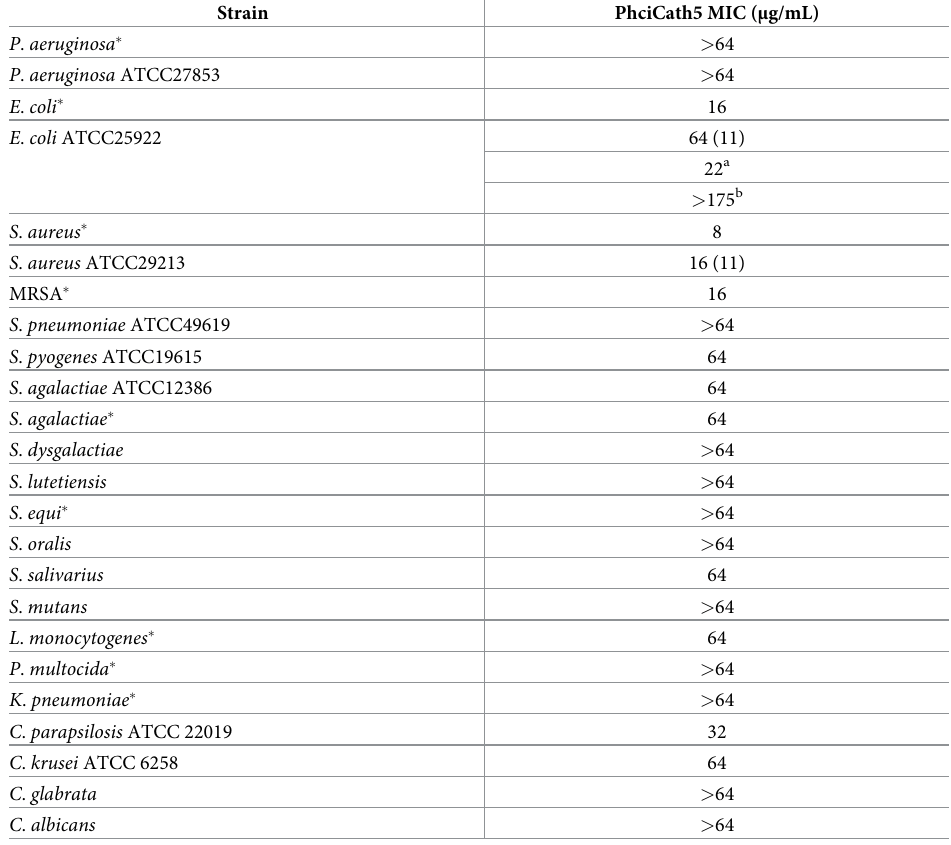
Table 2. Koala cathelicidin mature peptide PhciCath5 displays antimicrobial activity against bacteria and fungi from humans and animals, expressed as the minimum inhibitory concentration (MIC).